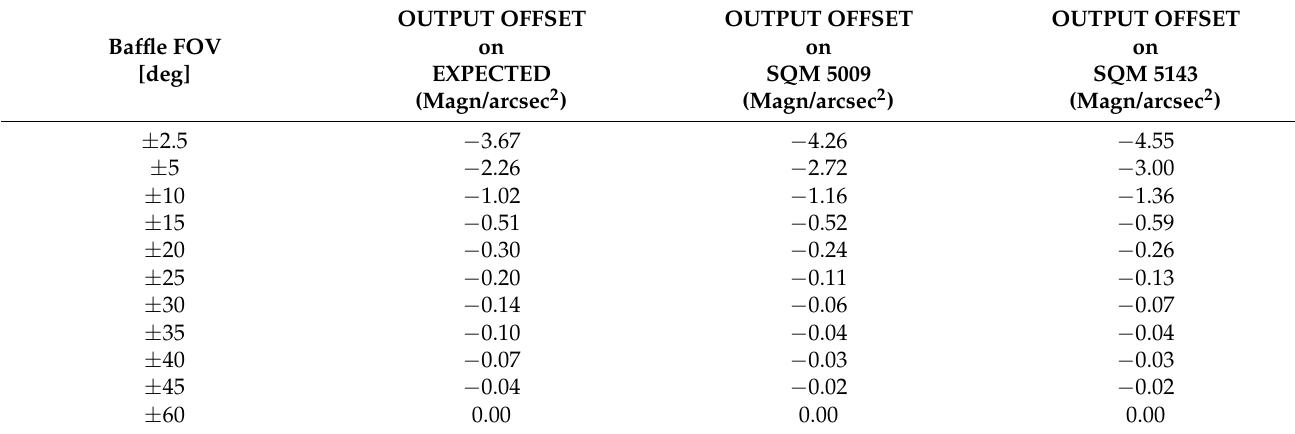
Table 3. Offset values introduced by the baffles with different FOV on the expected angular response reconstructed from the manufacturer datasheet and for the two SQM units under